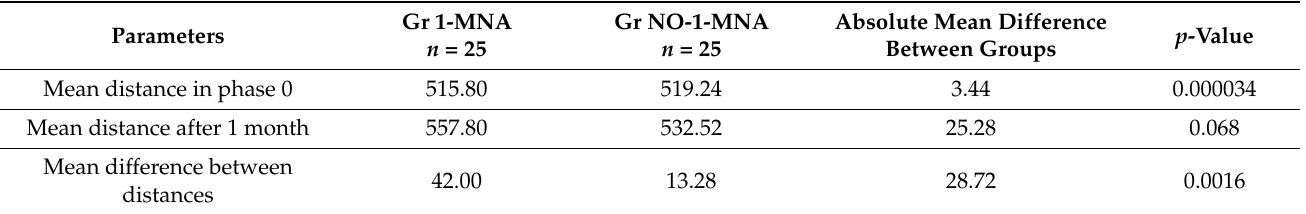
Table 2. Distance in 6 min walk test in the groups Gr NO-1-MNA and Gr 1-MNA at Phase 0 and after 1